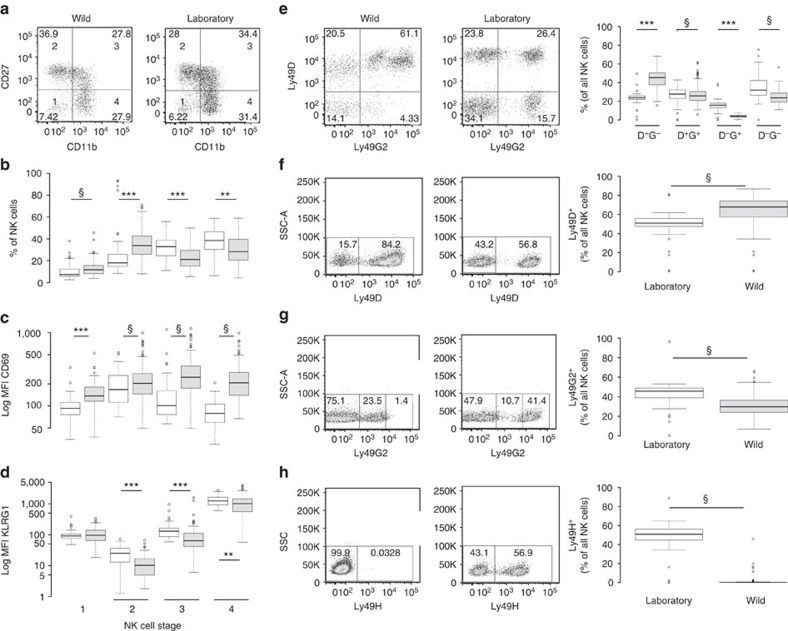
Splenic NK cells and Ly49 expression.(a) The flow cytometry gating strategy using expression of CD27 and CD11b to classify NKp46+ CD3− splenic NK cells of wild and laboratory mice into stages 1–4 of maturity, (b) the proportions of NK cells at each such stage, in wild (shaded) and laboratory (unshaded) mice, and expression of (c) CD69 and (d) KLRG1 by each subset (Table 2). Also shown are (e–h) the gating strategies for Ly49 receptors and the proportions of NK cells expressing, (e) different combinations of Ly49D and Ly49G2, (f) Ly49D, (g) Ly49G2 (Ly49G2+ cells gated into Ly49G2−, Ly49G2low and Ly49G2high cells) and (h) Ly49H. Wild mice are shown as shaded box plots, laboratory mice as unshaded. The box centres are medians, and box limits the 25th and 75th percentiles, the whiskers 1.5 times the interquartile range and outliers are represented by dots and some axes are on a log10 scale. Asterisks denote significant differences as **P<0.01, ***P<0.001 (Mann–Whitney U test; Table 2), and § denotes that there are additional sex effects detailed in Table 2. The gating strategy for NKp46+ CD3− lymphocytes is shown in Supplementary Fig. 1. Sample sizes are shown in Table 2 and Supplementary Data 1.